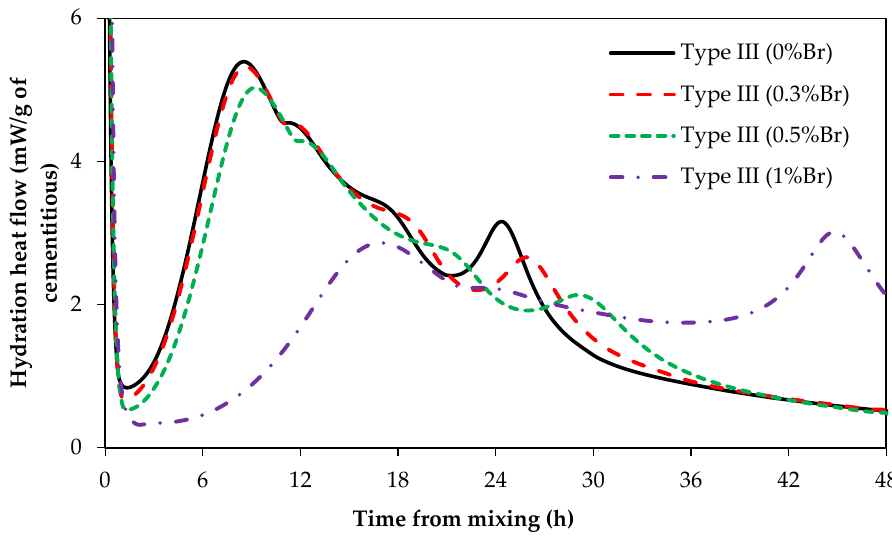
Figure 6. Type III hydration with and without borax .